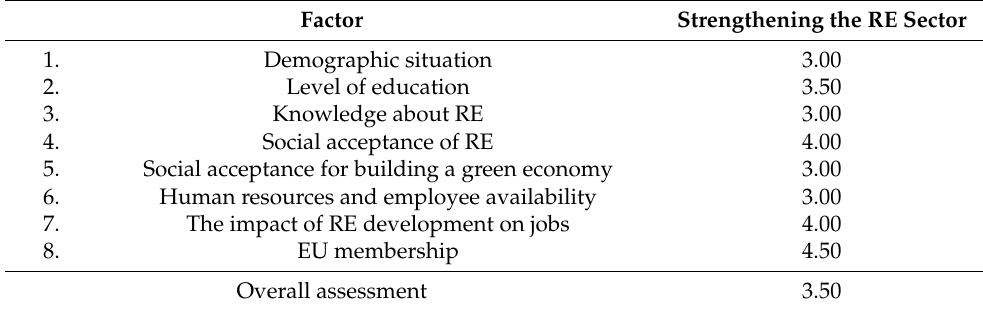
Table 3. Social environment of RE in the Pomerania Voivodeship (author’s own